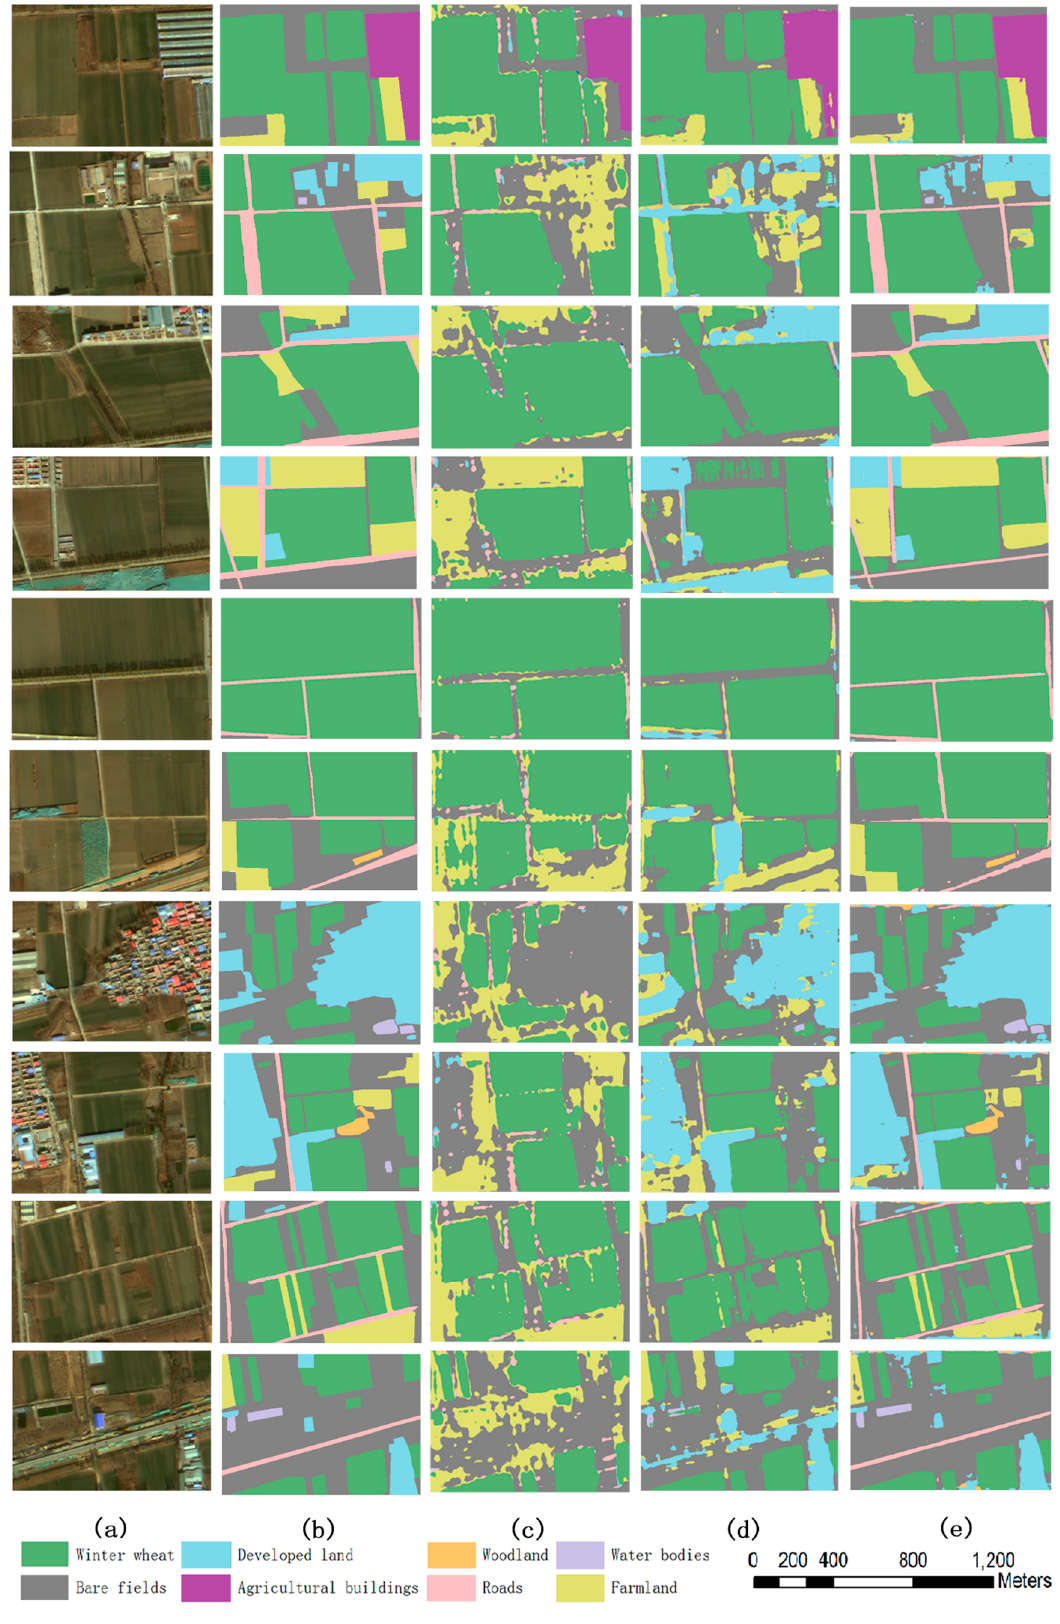
Figure 6. Comparison of segmentation results for Gaofen 2 imagery: ( a ) original images, ( b ) ground truth, ( c ) SegNet results, ( d ) RefineNet results, and ( e ) CEM results.